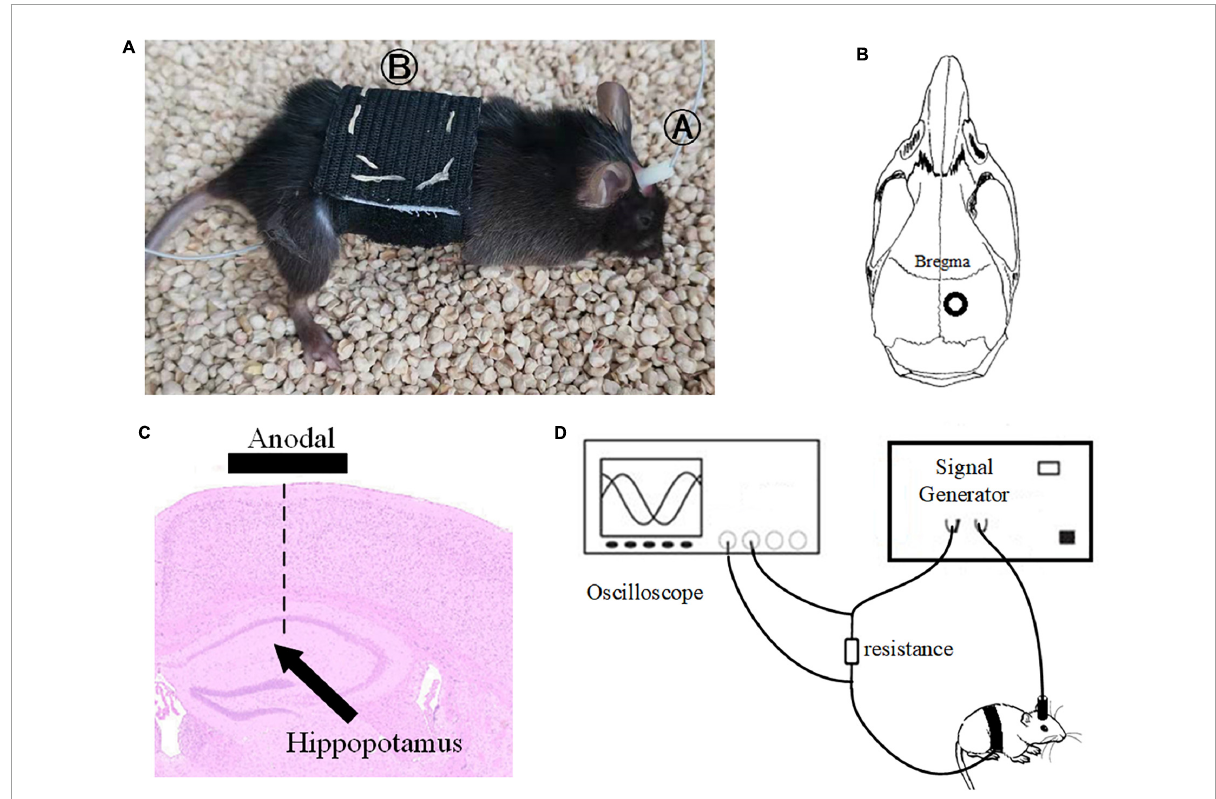
FIGURE2 Stimulation diagram. (A) Schematic diagram of mouse stimulation. A and B are two electrodes. (B,C) Stimulation target. (D) We used an oscilloscope to monitor the stimulation current in real time to ensure the efficiency of the stimulation